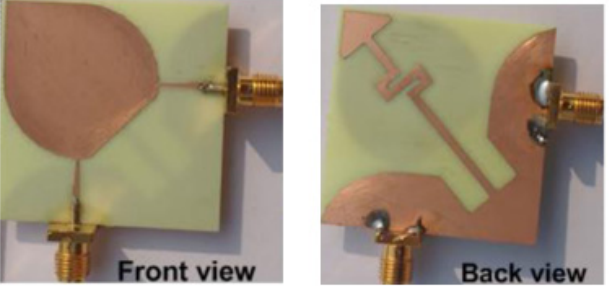
Figure 10. Front and bottom view of two port MIMO antenna design with common radiator [70].